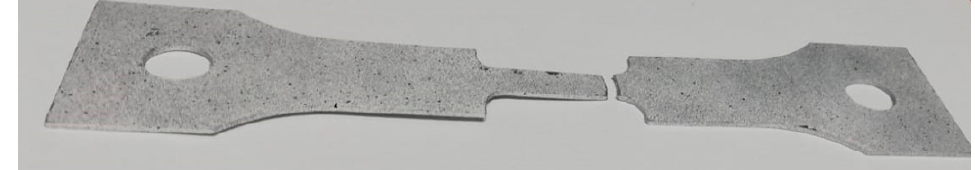
Figure 24. Tapered specimen after the tensile